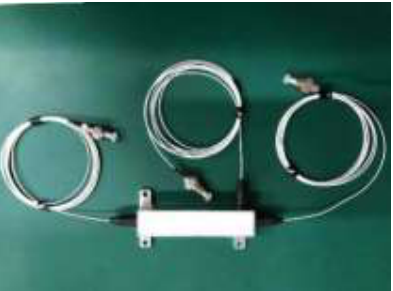
Figure 3. A photograph of the optical current sensing cell (OCSC) structure of the optical current sensor (OCS).